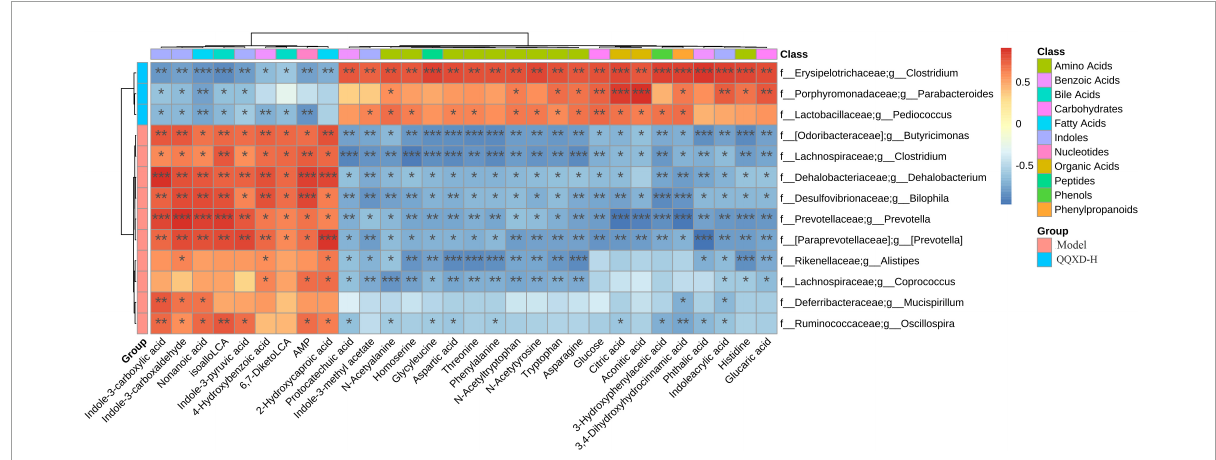
FIGURE8 The heat map of correlation analysis between gut microbiota and targeted metabolic profiling. * p <0.05, ** p <0.01, *** p